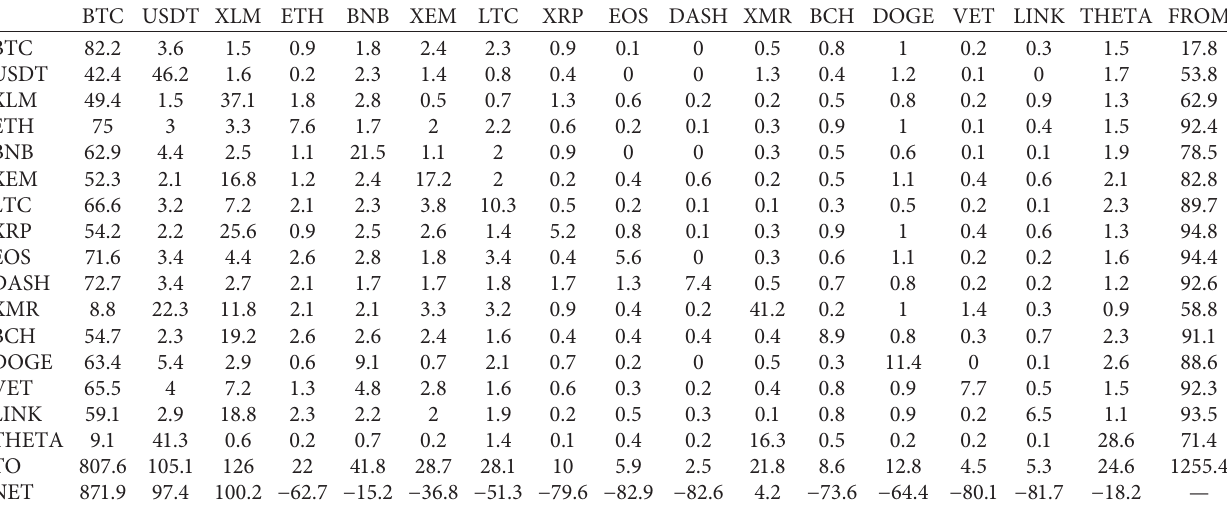
Table 5: DY index under